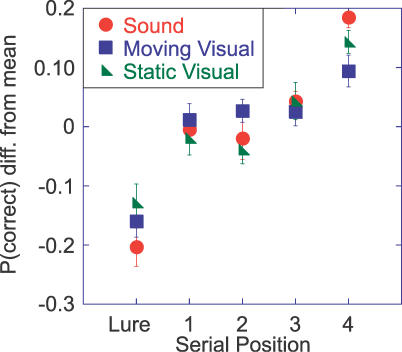
Effect of Serial PositionDifference from mean proportion correct responses (P(correct) diff) is plotted as a function of the serial position of the matching study item. Data are shown for the case in which four stimuli were presented. Statistics show a significant effect of serial position and list length, but no interaction between them. The mean proportions correct subtracted for each stimulus type were: sound, 0.72; moving visual, 0.62; and stationary visual, 0.61.